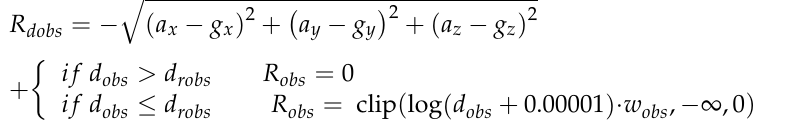
Figure 7. Electronic diagram of the head.